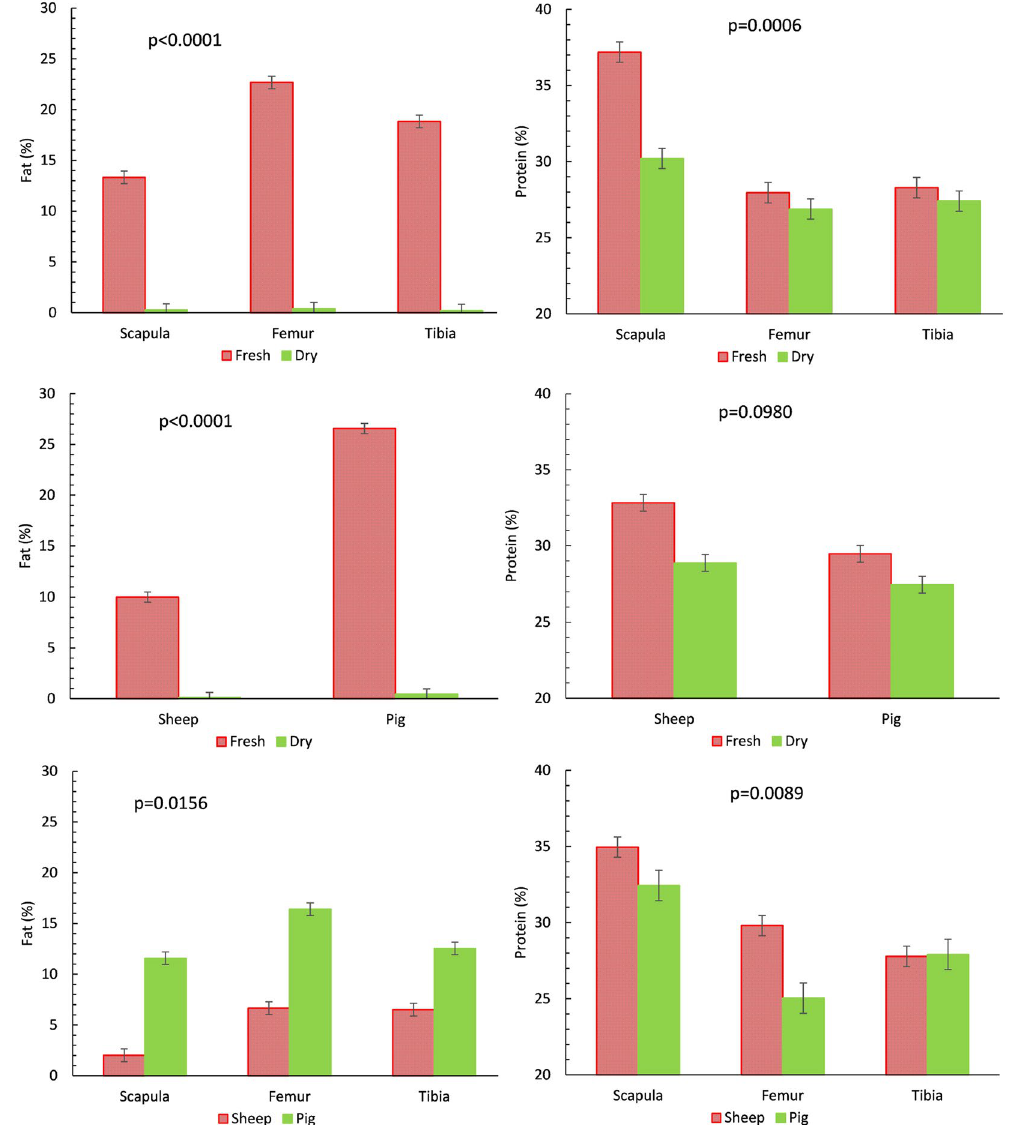
Figure 1. Fat and protein content for the interactions between anatomical part (scapula, femur and tibia), species (pig vs sheep), and age of the bones (fresh vs dry [ > 3months]). Bars represent ± s.e. P-values denote the significance of the interaction in the